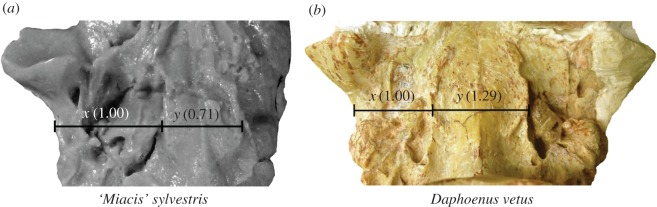
Illustration of Character AC10. Width (x) of basicranium lateral to lateral edge of basioccipital ventral floor compared with width (y) of basioccipital ventral floor at the level of external auditory meatus. (a) State 0 (y = 0.71x < x) in ‘Miacis’ cf. ‘M.’ sylvestris (FMNH PM 55953, cast of AMNH FM 129284); (b) State 1 (y = 1.29x > x) in Daphoenus vetus (FMNH PM 8388).